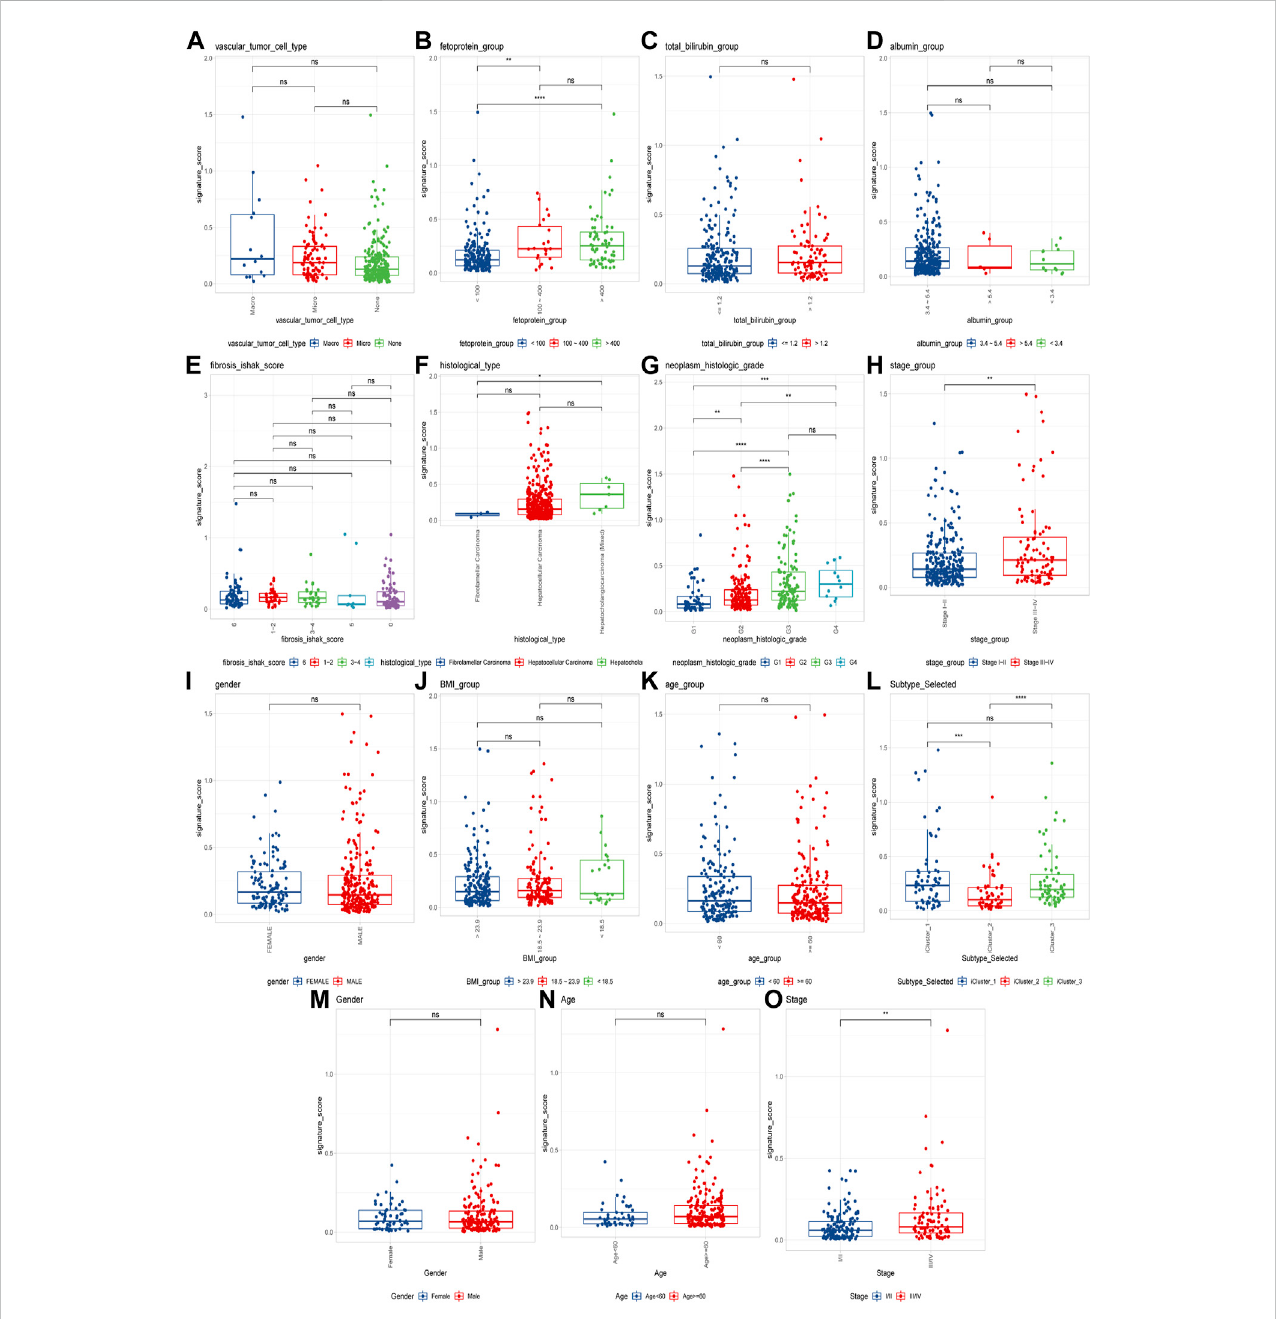
FIGURE 7 Cuproptosis-related genes signature correlates with clinical features. (A – L) Cuproptosis scores among different clinical features of hepatocellular carcinoma, including alpha-fetoprotein, total bilirubin, albumin, fi brosis score, histological type, histological grade, tumor stage, sex, BMI, age and molecular subtypes in TCGA cohort; (M – O) The differences of cuproptosis scores by gender, age, and tumor stage in the LIRI-JP cohort (ns: p > 0.05; *: p < 0.05; **: p < 0.01; ***: p < 0.001; ****: p <